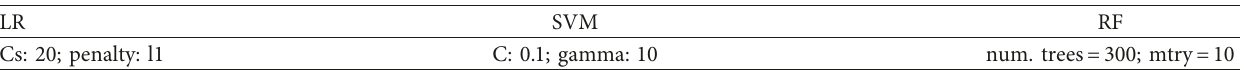
Figure 4: For retweeting interactions, new links between nodes from May 21 until May 26 in 2021. Table 11: For retweeting interactions from May 21 until May 26 in 2021, utilizing the obtained similarities between nodes, best hyperparameters for LR, SVM, and RF